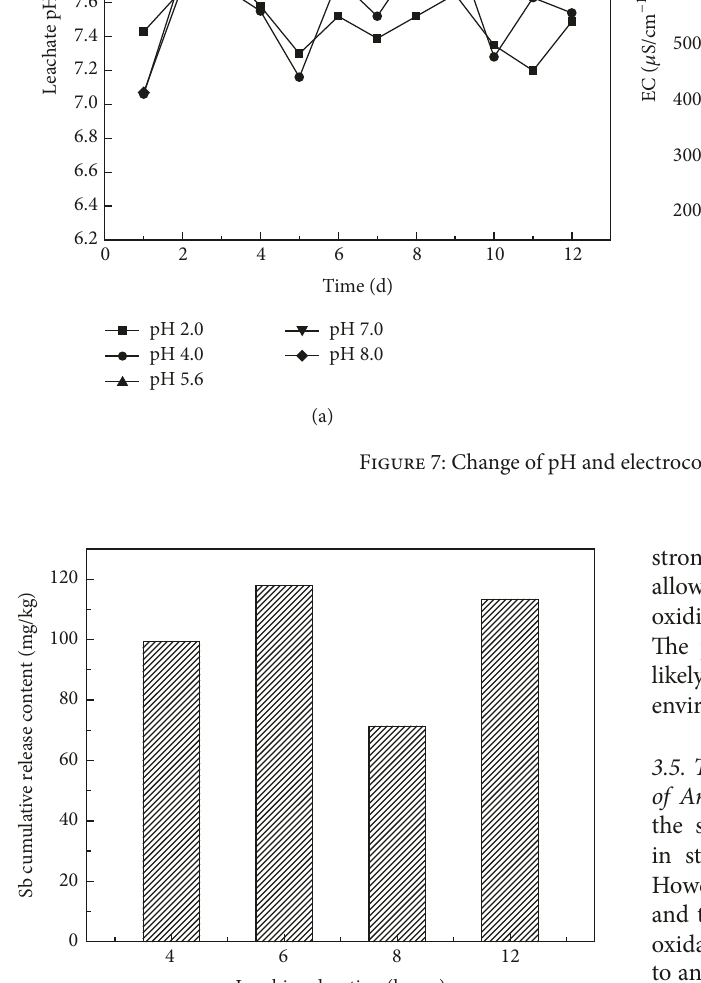
The decrease in leaching may also be due to the surface pores of slag becoming eroded, leading to surface collapse and reduction of the contact area between slag, water, and air. At longer leaching time, the slag may have become